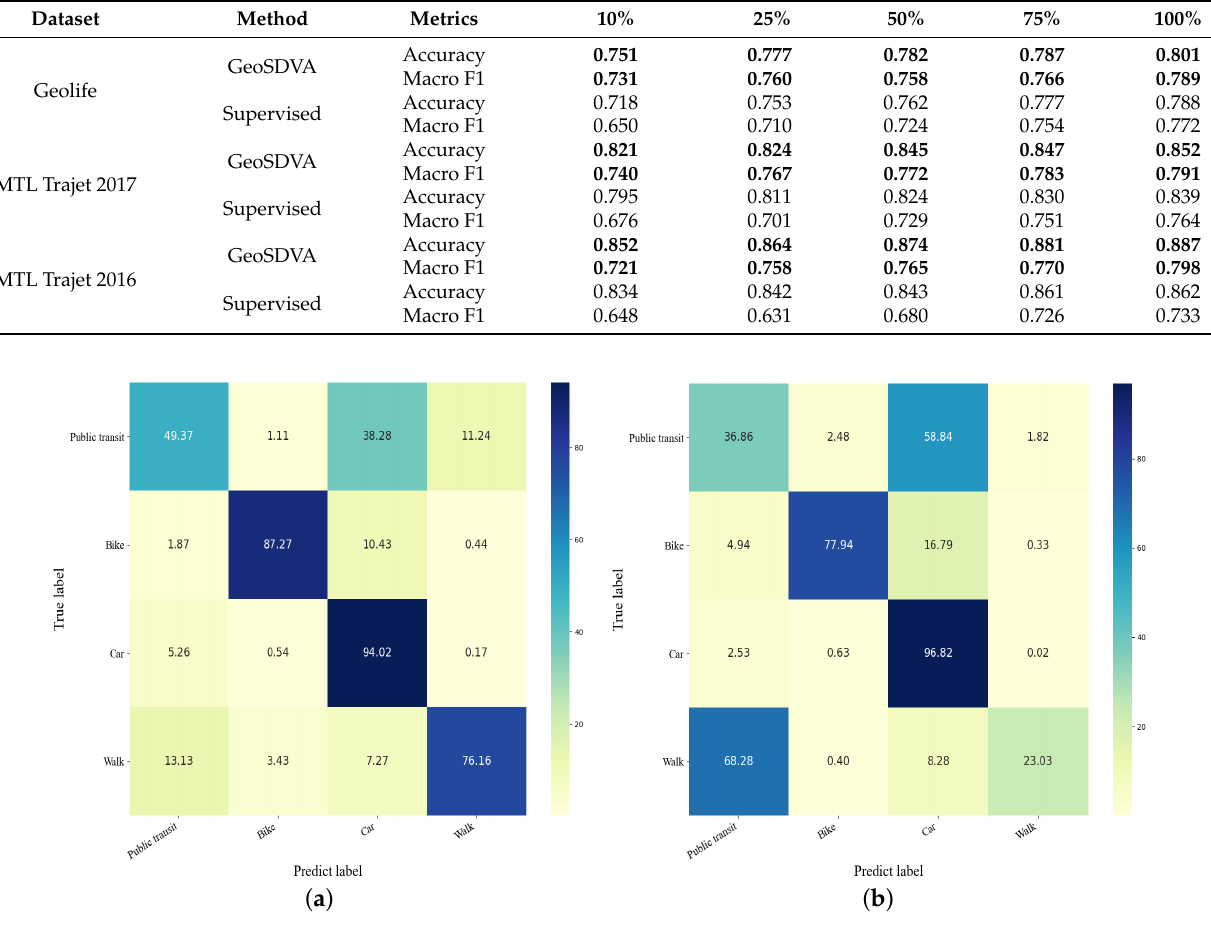
Figure 5. The comparison of the identification results. ( a ) GeoSDVA. ( b ) Supervised-GeoSDVA.